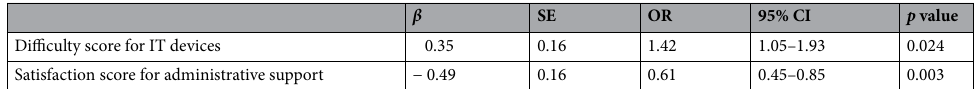
β SE OR 95% CI p value Difficulty score for IT devices